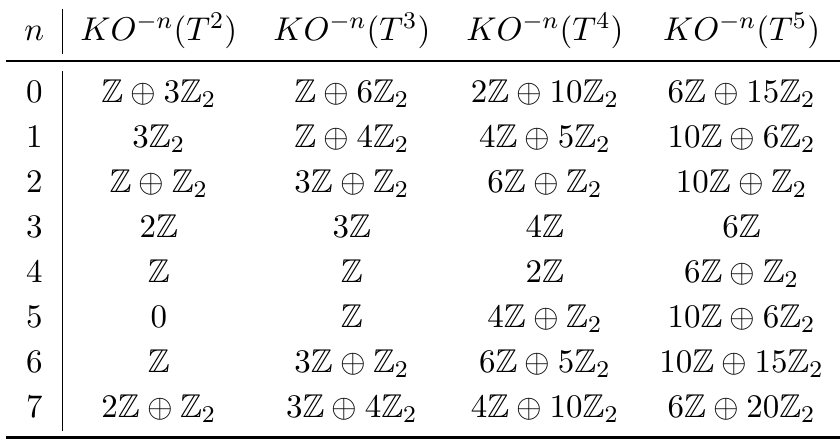
Table 30 . KO-groups of tori KO − n ( T k ) , k = 2 , . . . , 5 .